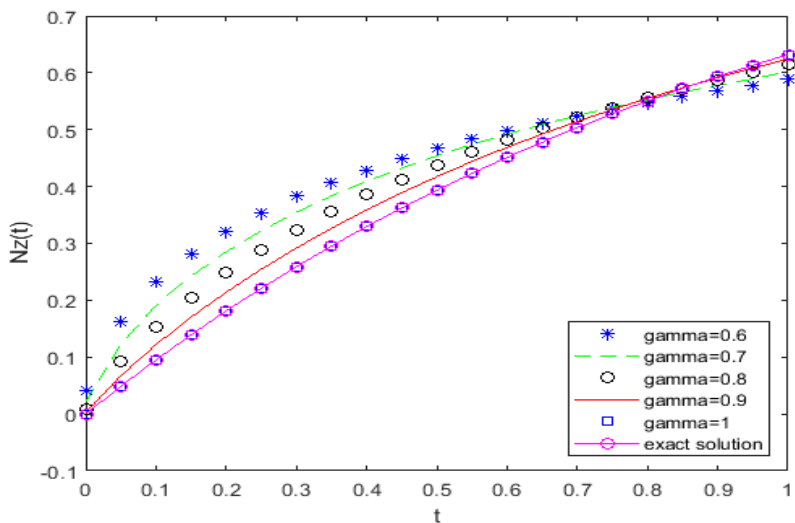
Figure 22. Behaviour of the approximate solution of N z ( t ) at γ = 0.6, 0.7, 0.8, 0.9 and 1, with parameters: 𝑤 (cid:2868) = 1 , 𝑇 (cid:2869) = 1 , 𝑇 (cid:2870) = 20, 𝑎 = 1, 𝑏 = 1 .